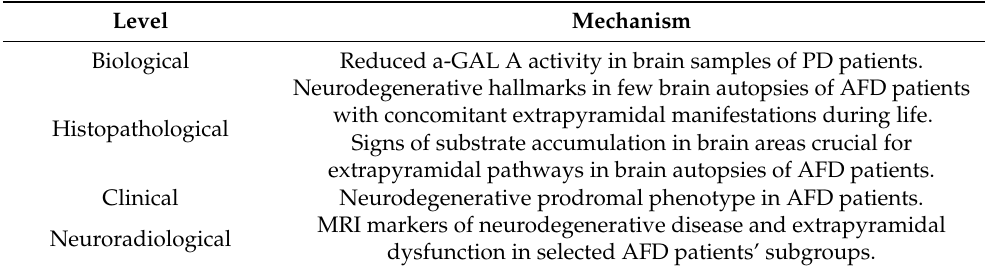
Table 1. Summary of the levels of an association between AFD and extrapyramidal phenotype. Level Mechanism Biological Reduced a-GAL A activity in brain samples of PD patients. with concomitant extrapyramidal manifestations during life. Histopathological Signs of substrate accumulation in brain areas crucial for extrapyramidal pathways in brain autopsies of AFD patients. MRI markers of neurodegenerative disease and extrapyramidal dysfunction in selected AFD patients’